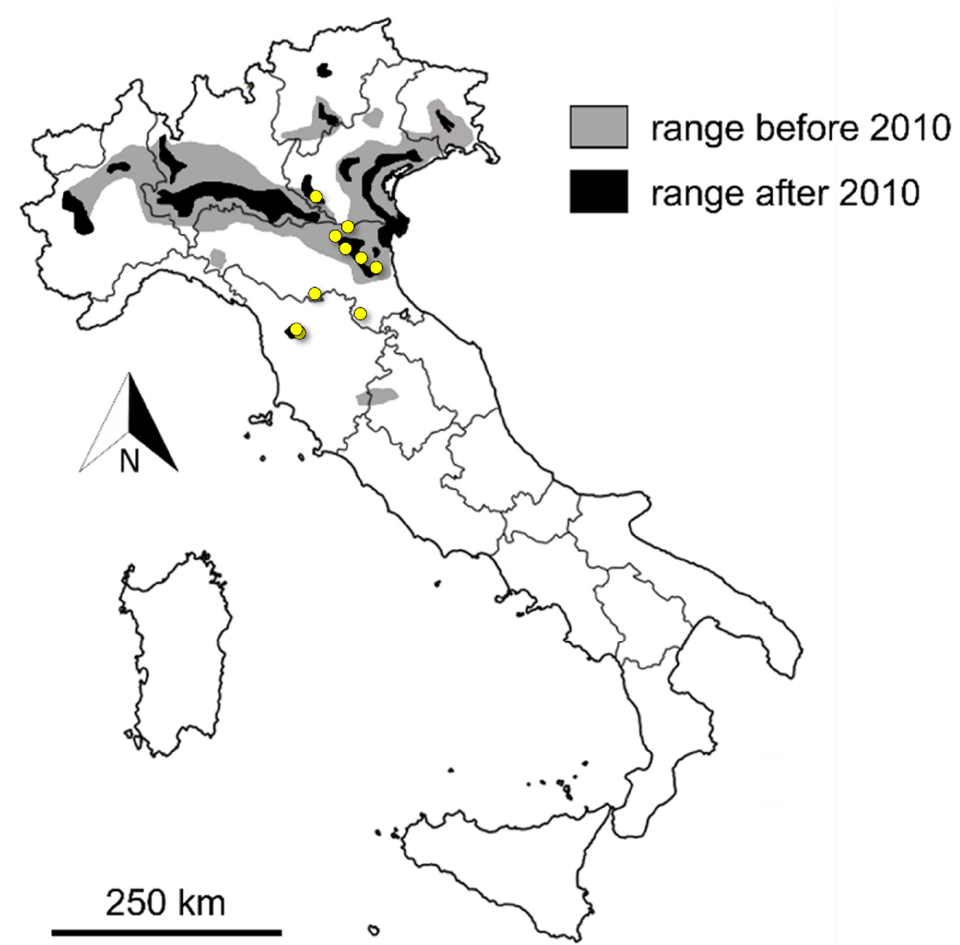
Figure 1. Past (2000–2010) and present (2010–2022) distribution of Micromys minutus in Italy [31–33]. Yellow dots represent sampling sites. As to Central Tuscany (Padule di Fucecchio), first records date back to 1990s and have been recently confirmed [34].